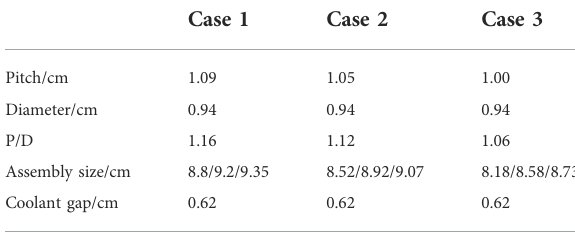
TABLE5Geometryparametersofthepitch-to-diameterratioanalysis.